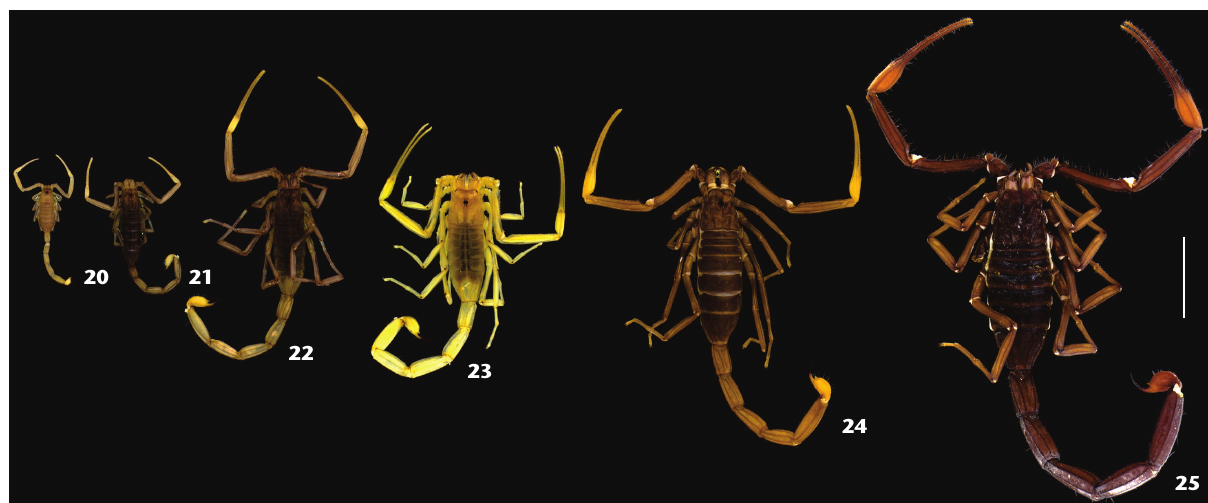
Figures 20-25. Troglorhopalurus translucidus at different stages, except litter: (20) stage 2; (21) stage 3; (22) stage 4; (23) male holotype; (24) female subadult; (25) female adult. The stage 5 female is not represented. Scale bar: 10